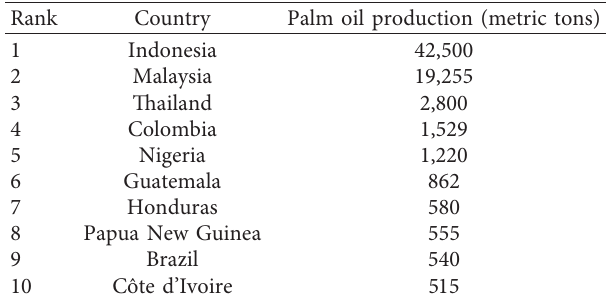
Table 7: List of countries with the highest palm oil production in the world [141,